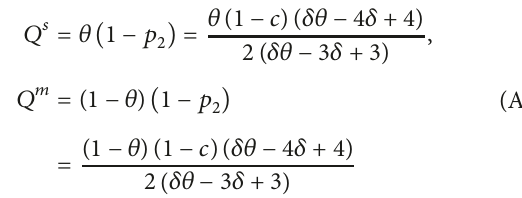
Figure 7: The case when technology advancement is costly.